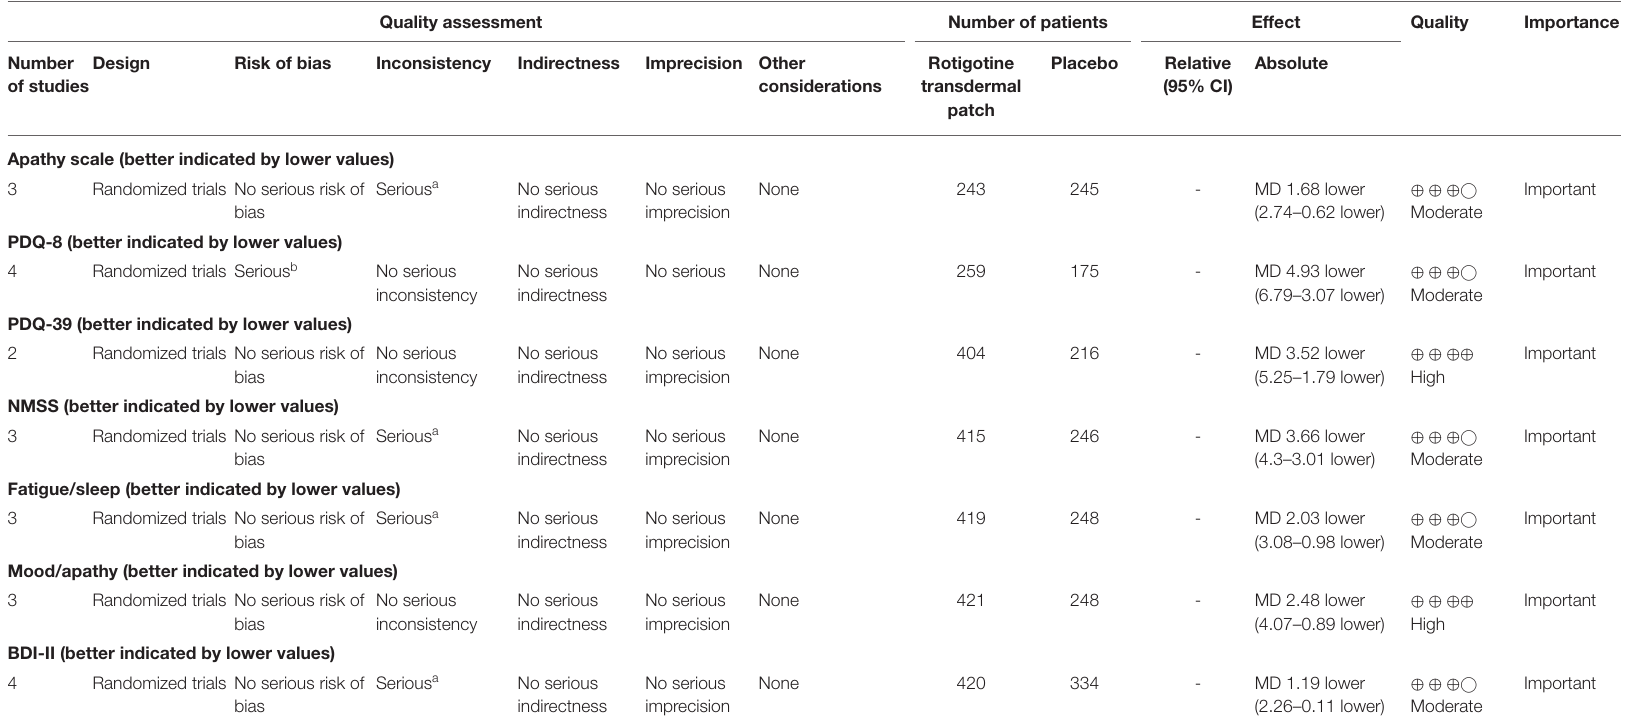
TABLE 5 | The GRADE evidence